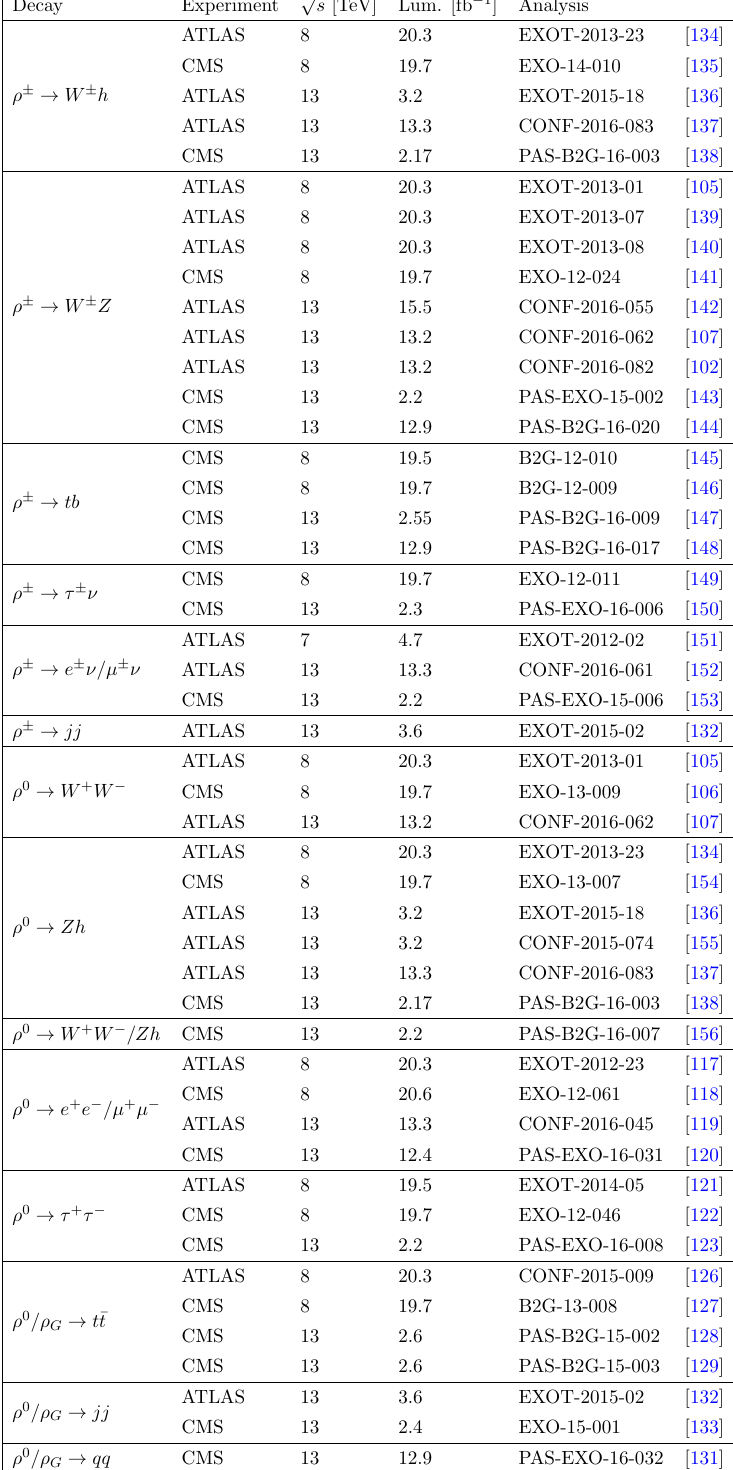
Table 3 . Experimental analyses included in our numerics for heavy vector resonance